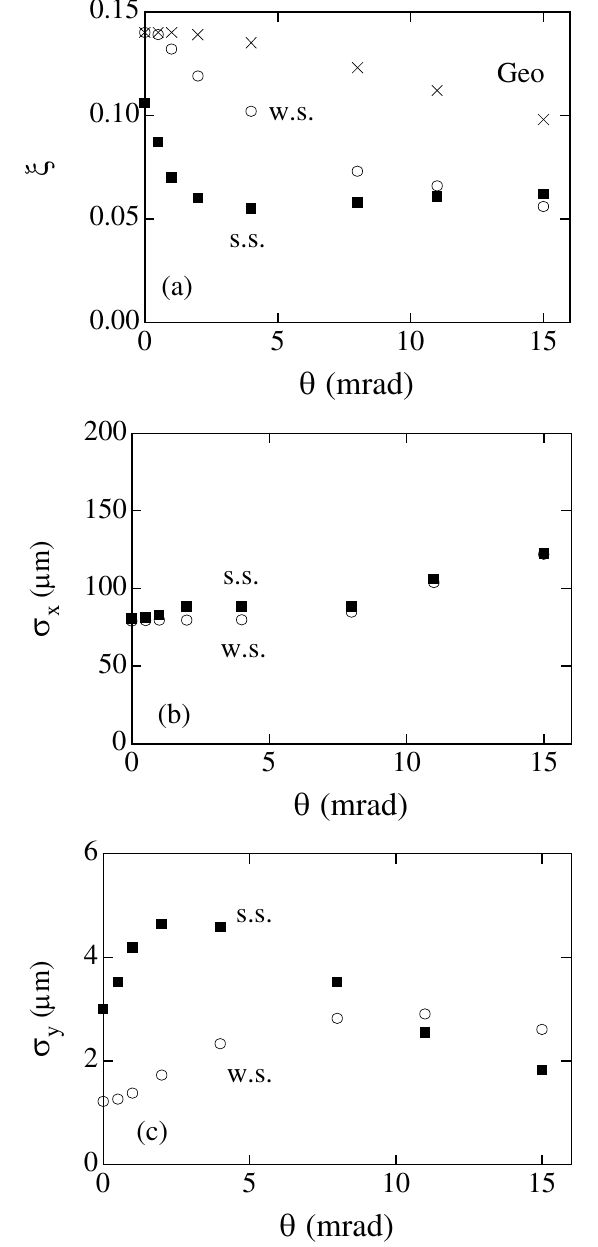
FIG. 4. Beam-beam parameters and beam sizes as a function of crossing angle. The beam-beam parameter, horizontal and vertical beam sizes, which are obtained by the strong-strong and weak-strong simulations, are depicted in (a)–(c), respec-